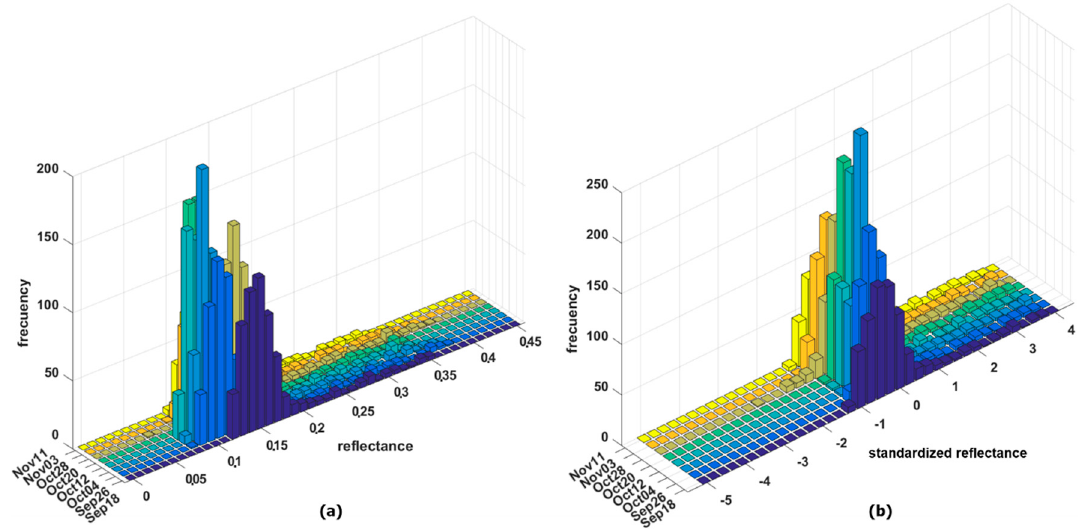
Figure 5. Comparison between multitemporal reflectance histograms ( a ) for band 1 (426 nm), and standardized reflectance histograms ( b ) after applying a transformation.